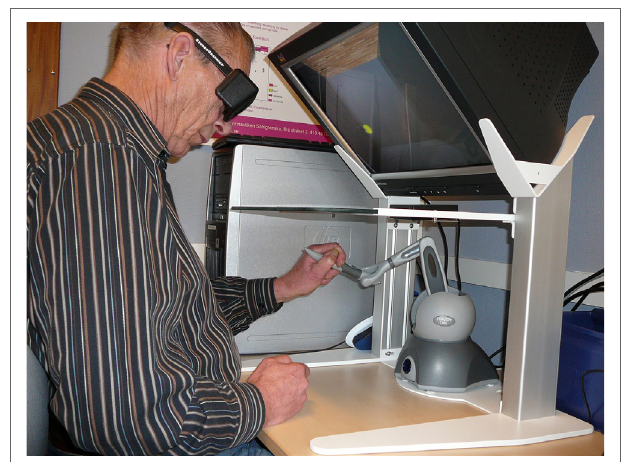
FigUre 2 | A participant wearing 3D glasses and performing the target- to-target task using the haptic device.